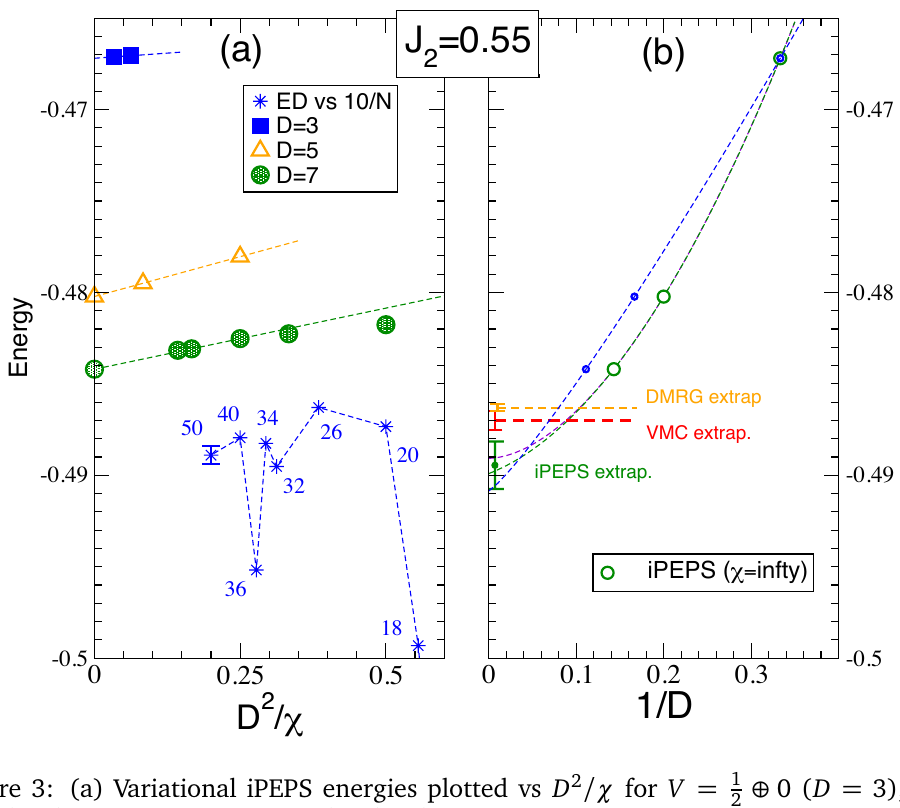
⊕ 1 ⊕ 1 ⊕ 0 ( D = 7). Dashed lines are linear fits. 2 2 2